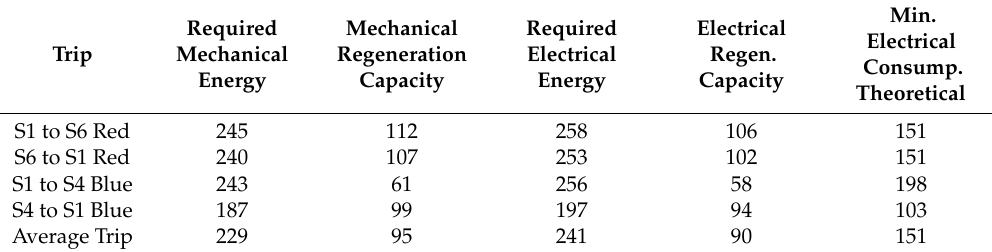
Table 2. Summary of the train behavior in the different trips; all data are in kWh.